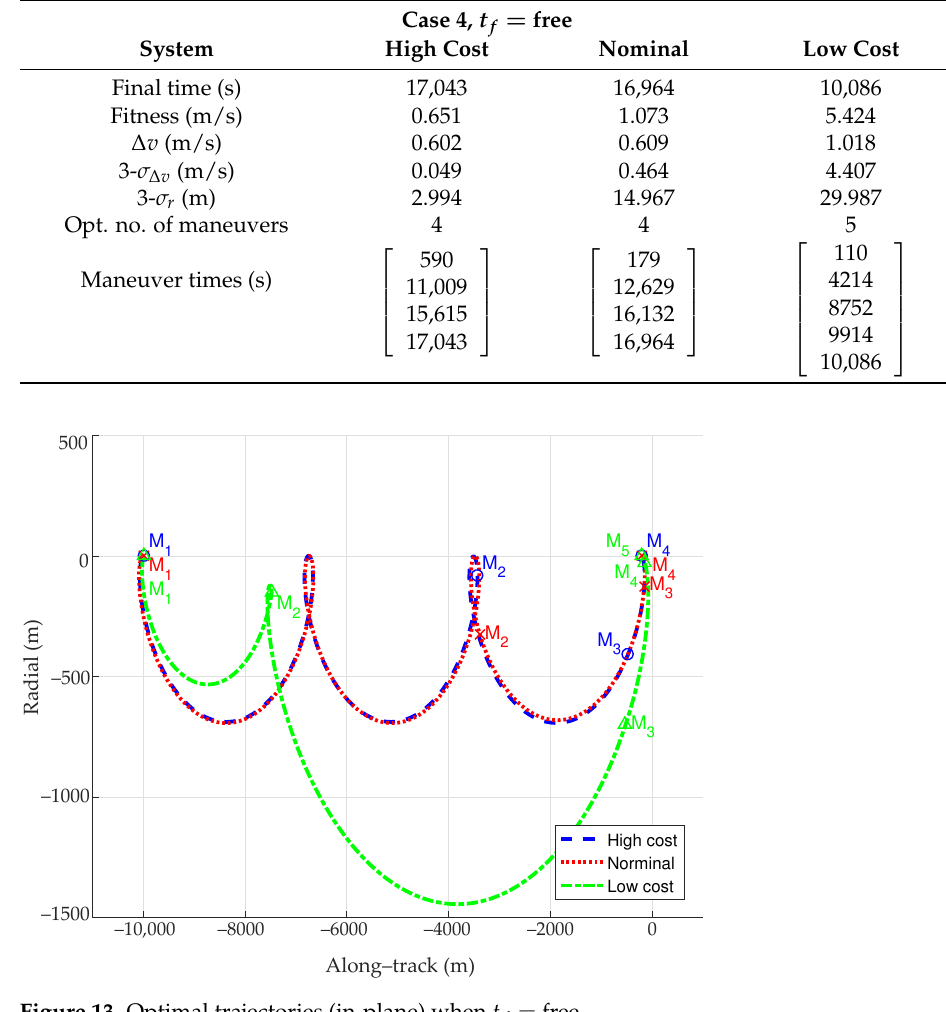
Figure 13. Optimal trajectories (in-plane) when t f = free.